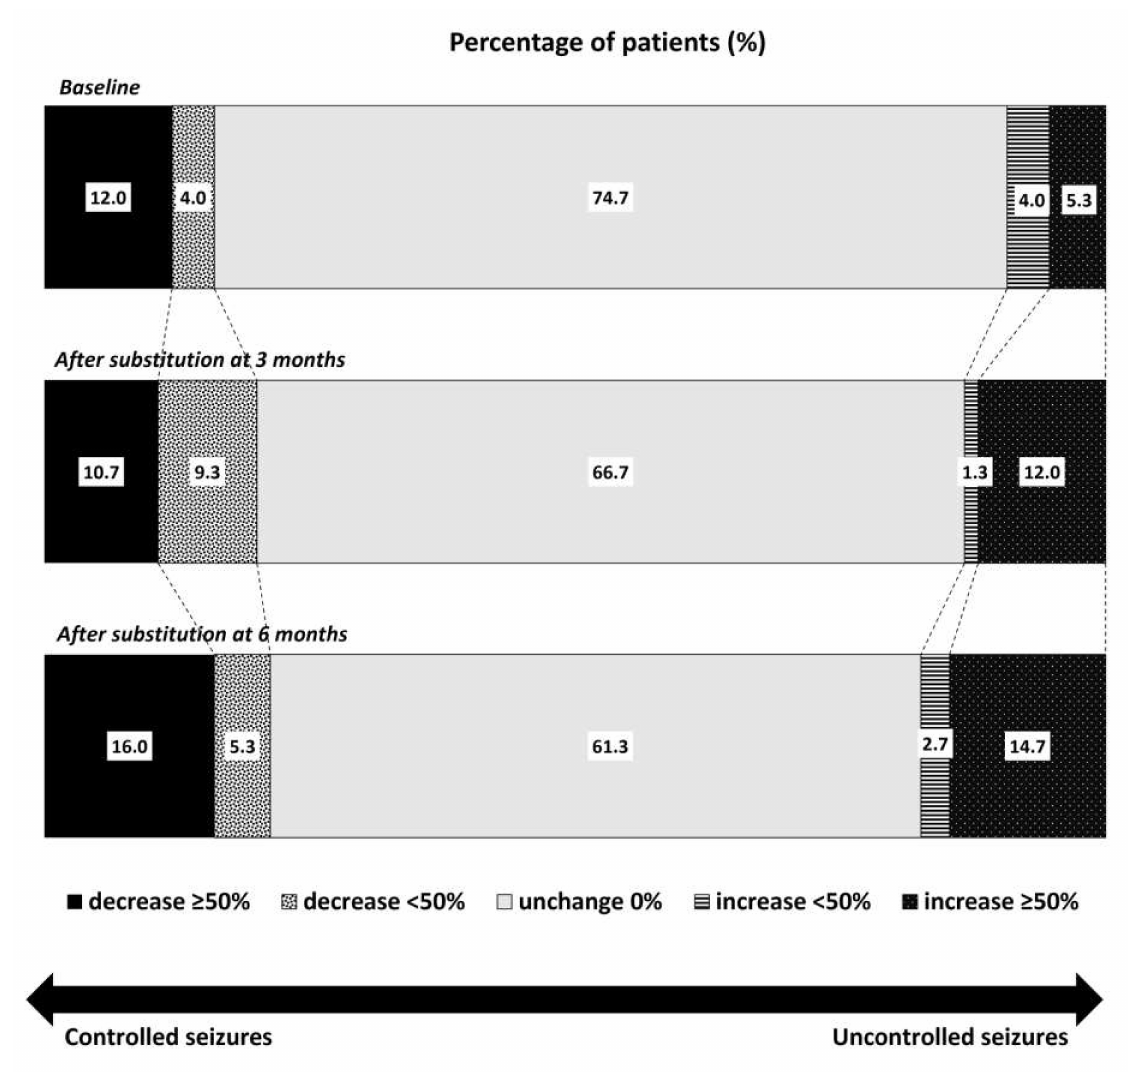
Figure 1. Comparison of the percentage of patients with controlled or uncontrolled seizures accord- ing to the changes in seizure frequency between baseline and three months and six months after levetiracetam substitution with the generic